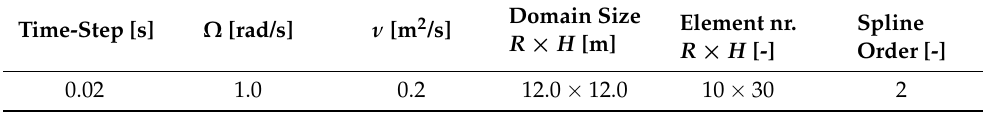
Table 2. Parameters used for the von Kármán swirling flow